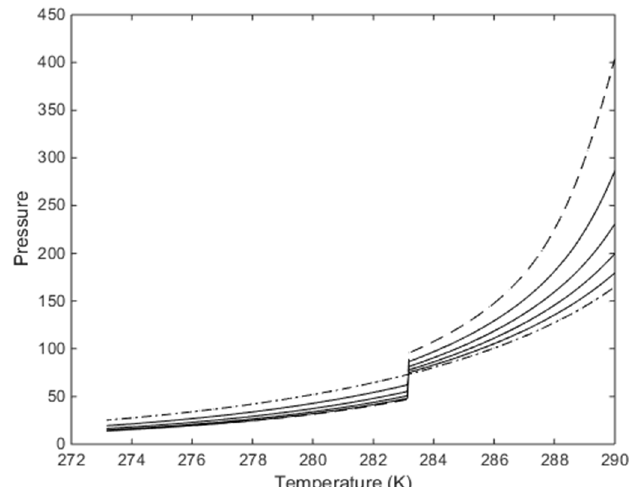
Figure 8. Stability limits for pure CH 4 hydrate (pressure in bars) is plotted as dash-dot curve while stability limits for pure CO 2 hydrate (pressure in bars) is plotted as dashed curve. Solid curves are from bottom to top 20 mole per cent CO 2 , 40 mole per cent CO 2 , 60 mole per cent CO 2 and top solid curve is for 80 mole per cent CO 2 . Pressure in all these curves are in bars. Note the rapid change in pressure for all the curves containing CO 2 , which is due to phase transitions but is absent in many published data.